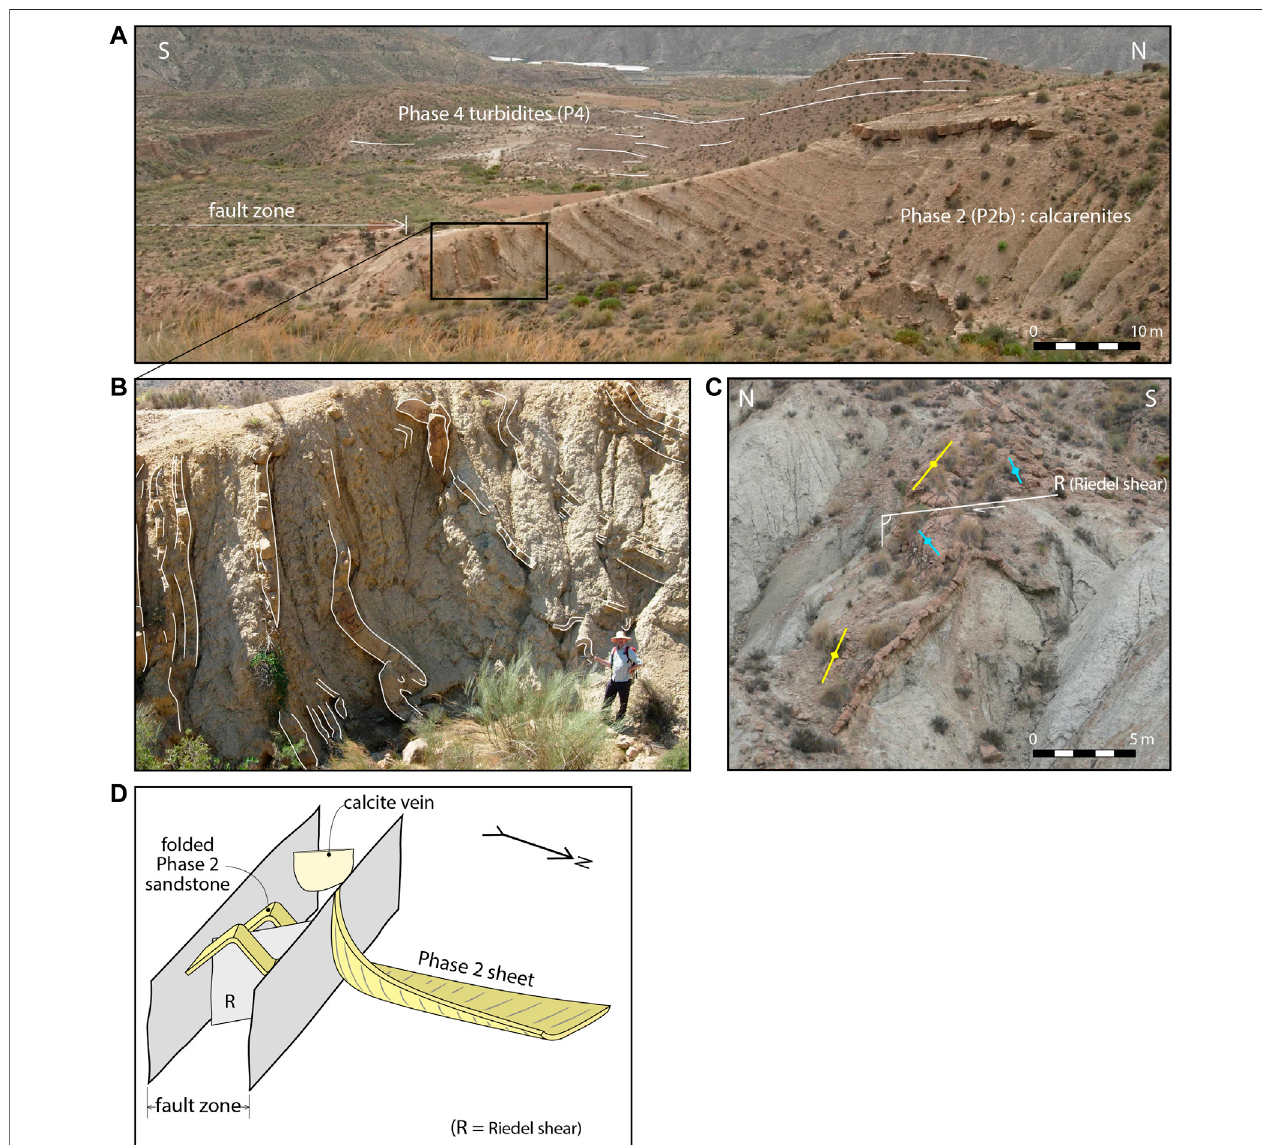
FIGURE 7 | Field photographs and fault reconstruction illustrating the character of the faulted southern margin of the Alfaro sub-basin (see Figure 4 for location) (A) Progressive rotation of Phase 2 calcarenites against the northern side of the fault zone indicating dextral motion on the fault zone with a component of downthrow to the north. Relatively undisturbed Phase 4 turbidites occur on the far side of the fault (highlighted in white) and overstep it without displacement (B) Close-up ofrelatively ductiledeformation ofPhase2sandstonebeds (highlighted in white) againstthefault (C) Deformed calcareniticsandstonebed withinthe southernmarginfaultzoneexhibitingpairofverytightparallelanticlines(highlightedinyellowandblue)cutandoffsetbyadextralRiedelshearminorfault(highlighted in white) (D) Sketch summarising the deformation within and against the oblique slip fault on the southern margin of the Alfaro sub-basin (dextral strike-slip + downthrown to the north).